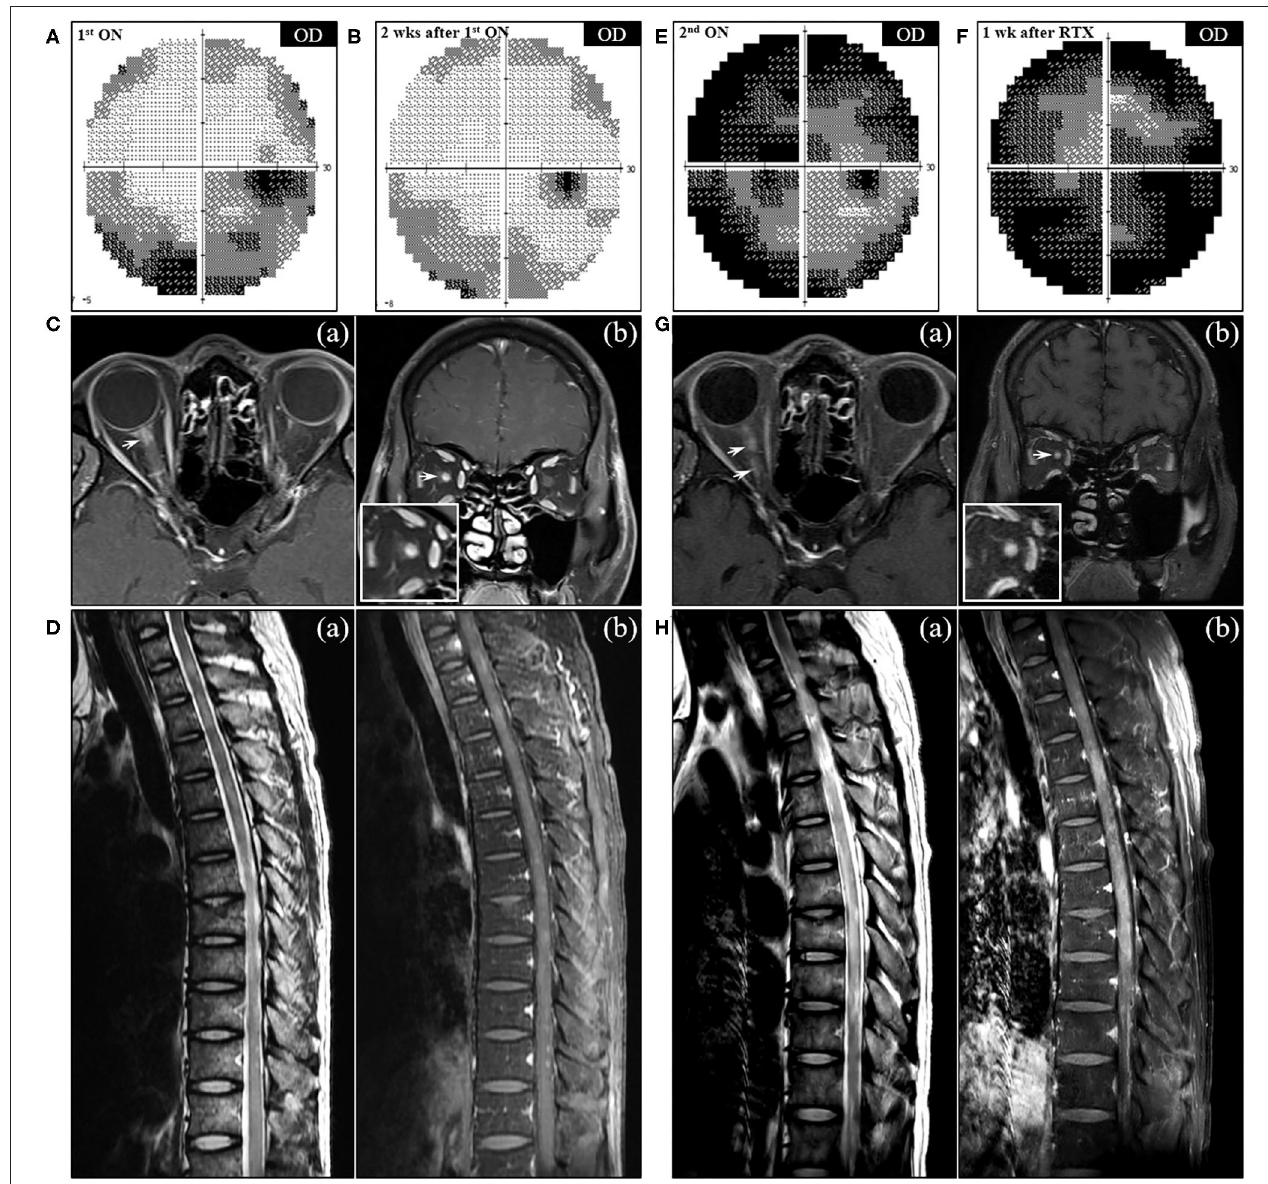
FIGURE 3 | Serial visual field tests and MRI findings of NMO in the patient. (A) The initial visual field (VF) test demonstrated the incomplete loss of the inferior and peripheral vision in the right eye, which partially improved after corticosteroid therapy (B) . (C) Axial (a) and coronal (b) T1-weighted orbit MR images showed contrast enhancement in the right optic nerve at the back of the eye (arrow). (D) Sagittal MRI of the thoracic spine showed multifocal T2-hyperintensity (a) with patchy contrast enhancement (b). (E) VF test performed at the second attack of ON showed near-total blindness of the right eye, which was exacerbated to complete blindness a week after rituximab injection (F) . (G) Follow-up orbit MRI showed the contrast-enhancing lesions (arrows) affecting the entire right optic nerve on the axial (a) and coronal (b) T1-weighted images. (H) Follow-up spine MRI after the second rituximab injection showed long segmental T2-hyperintensity (a) with diffuse enhancement (b) in the thoracic cord extending from T4 to T11 vertebral levels. OD, oculus dexter.